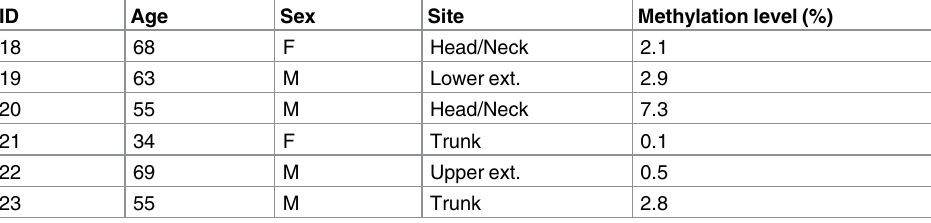
Table 2. Characteristics of the normal epidermis sample donors and methylation levels of the